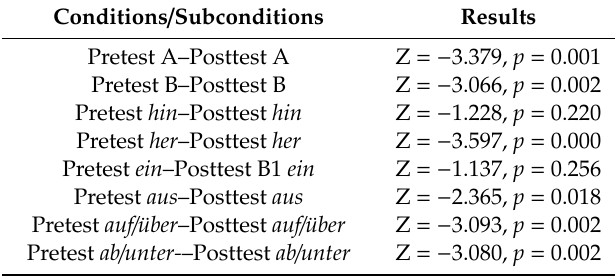
Table 4. Results of a series of Wilcoxon tests for the Conditions and Subconditions of the binary-choice recognition task in the pretest and the